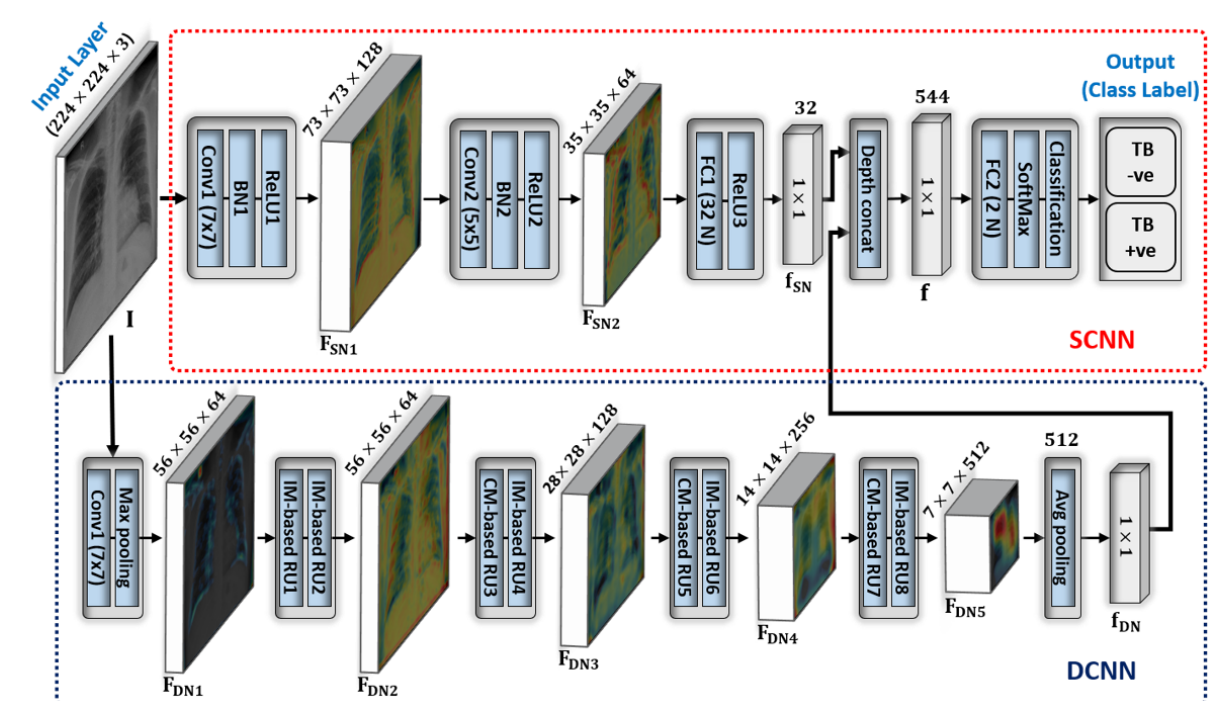
Figure 2. Overall architecture of our ensemble-SDCNN model by connecting 2 different networks, SCNN and DCNN. Both networks process the input image I simultaneously (in the testing phase) and extract 2 different feature vectors, which are concatenated and finally used to make a diagnostic decision by predicting the CL. CL: class label; CNN: convolutional neural network; DCNN: deep CNN; SCNN: shallow CNN; SDCNN: shallow–deep